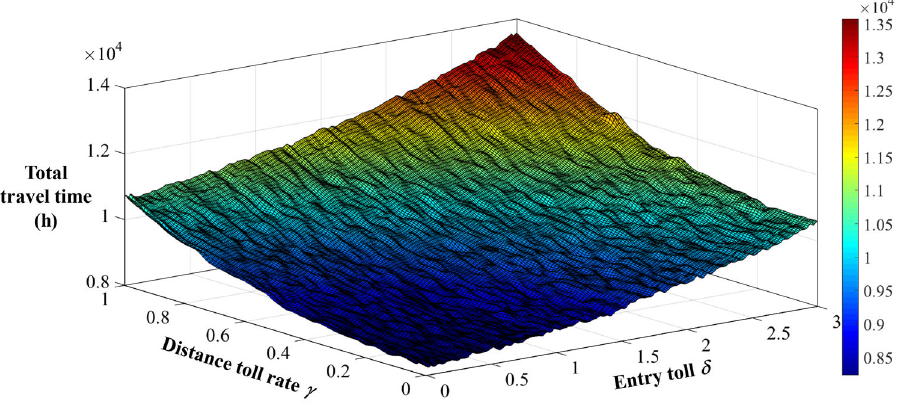
Fig. 5 Variation of total travel time with toll levels for Sioux